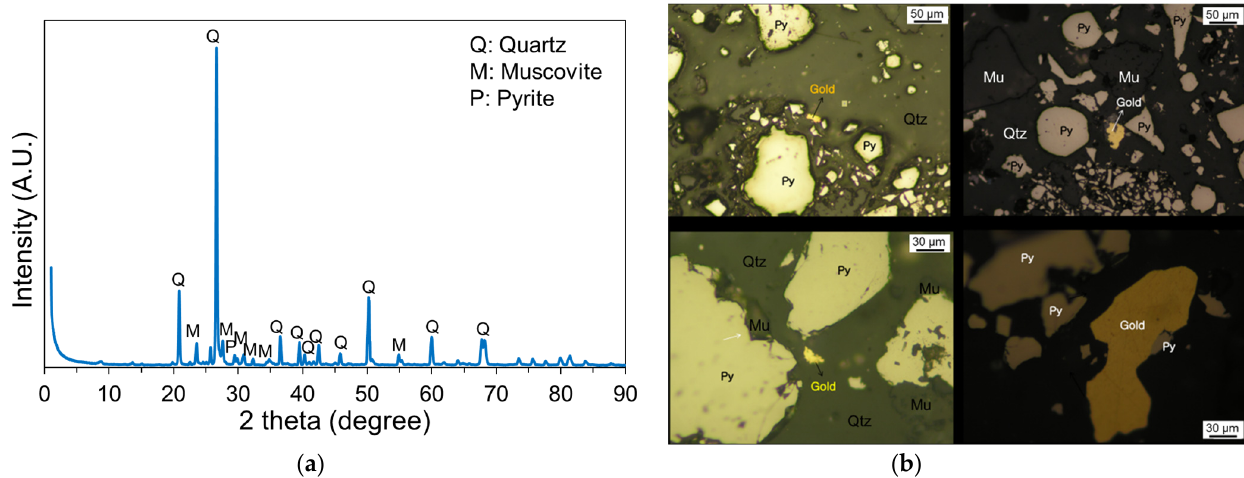
Table 2. Mineral composition of gold ore.